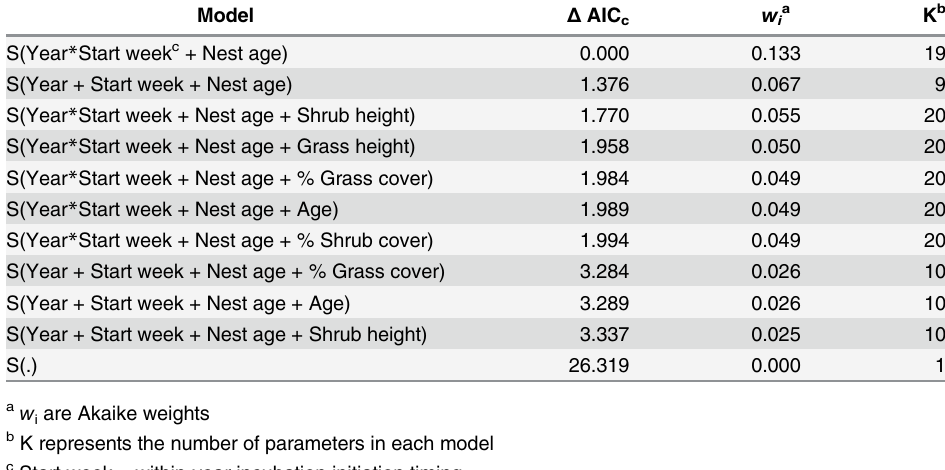
with five and six renesting attempts respectively. All renesting attempts were by adult females. Average nest initiation varied by study population and year but not by female age. Across all years, average nest initiation date was 8 May (+-9.8 standard error) in Gunnison Basin and 20 May (+- 16.4 standard error) in San Miguel. In 2008 in Gunnison Basin, the average initiation was shifted to17 May (+- 8.4 standard error) corresponding with heavy snowfall that spring (n = 35). The latest average initiation in San Miguel was in 2010 at 1 June (n = 7). Model uncertainty was considerable; thus, we employed model averaging for daily nest sur- vival rates. Nest age, year, and start week were consistently in the top ranked models (Table 1) ( > 0.99, Table 2). Cumulative w near one indicate strong and had similarly large cumulative w i i support for a covariate, any covariates with cumulative w less than 0.5 are relatively not i